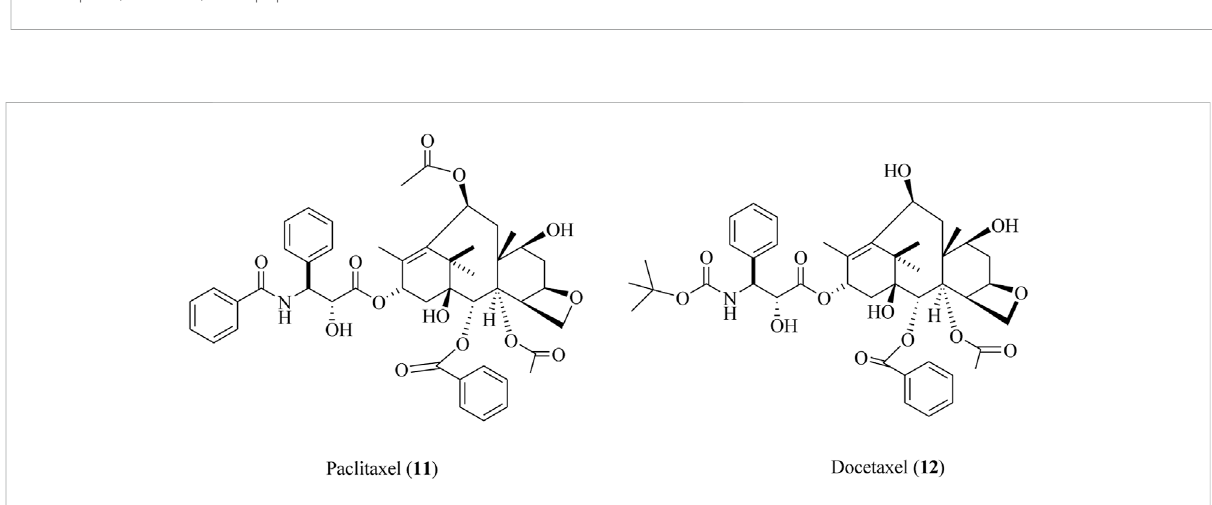
FIGURE 13 Structures of paclitaxel and its semi-synthetic derivative,